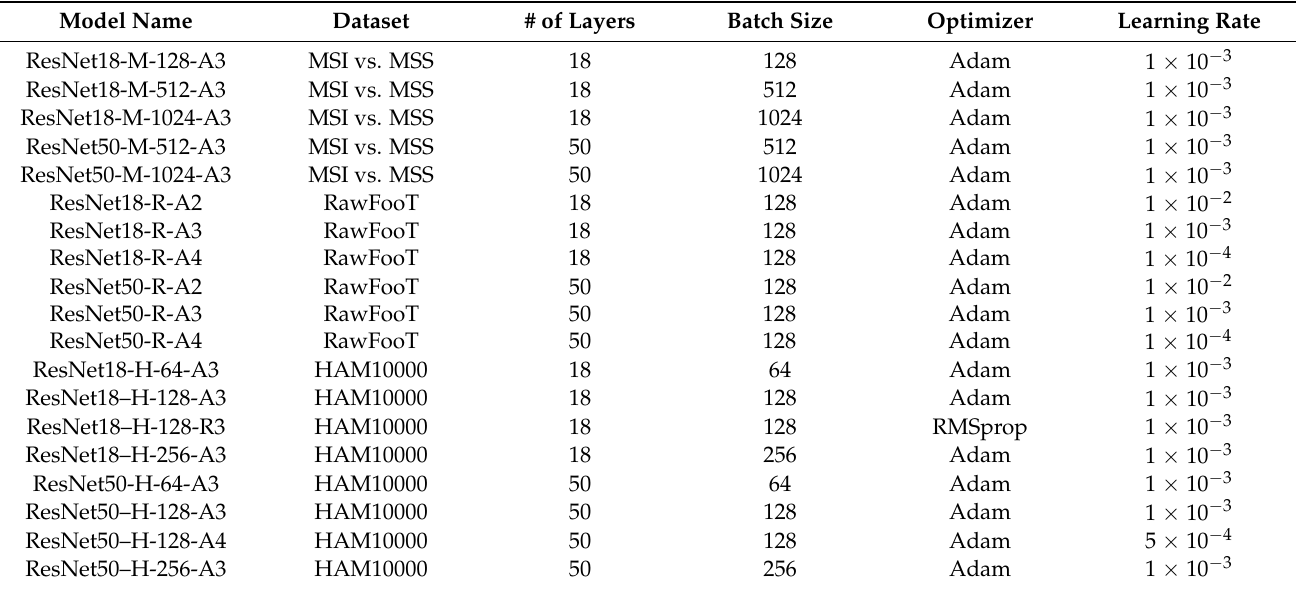
Table A1. Hyperparameters tested for pretraining models.